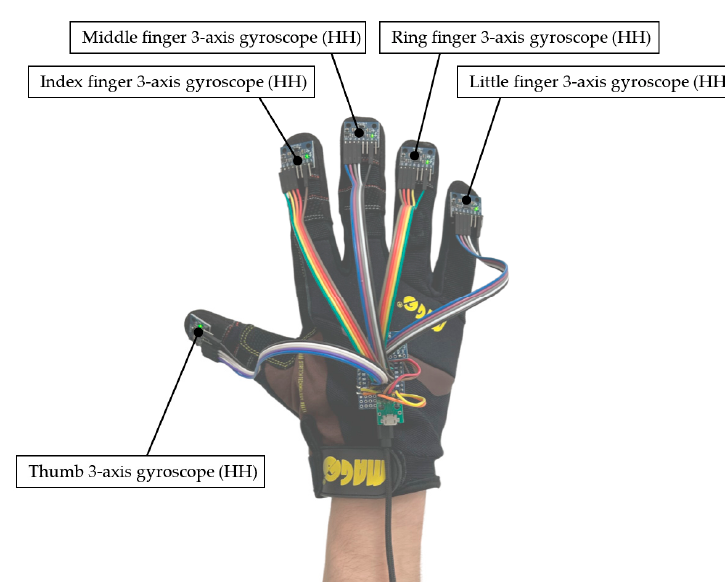
Figure 8. The design of the glove for prosthesis control.